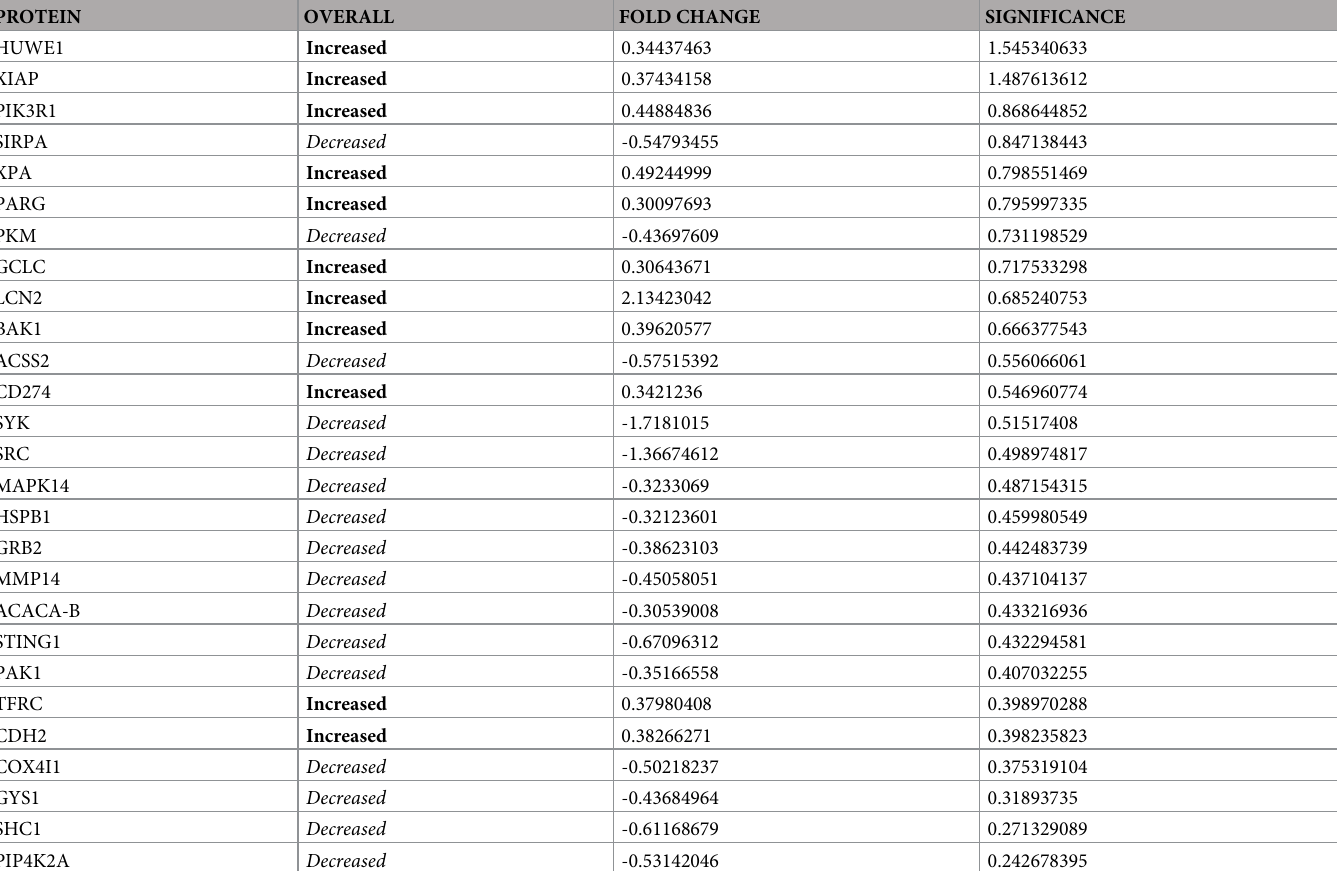
Table 2. Proteins from volcano plot which had notable increases or decreases listed in order of greatest to least significance (adjusted